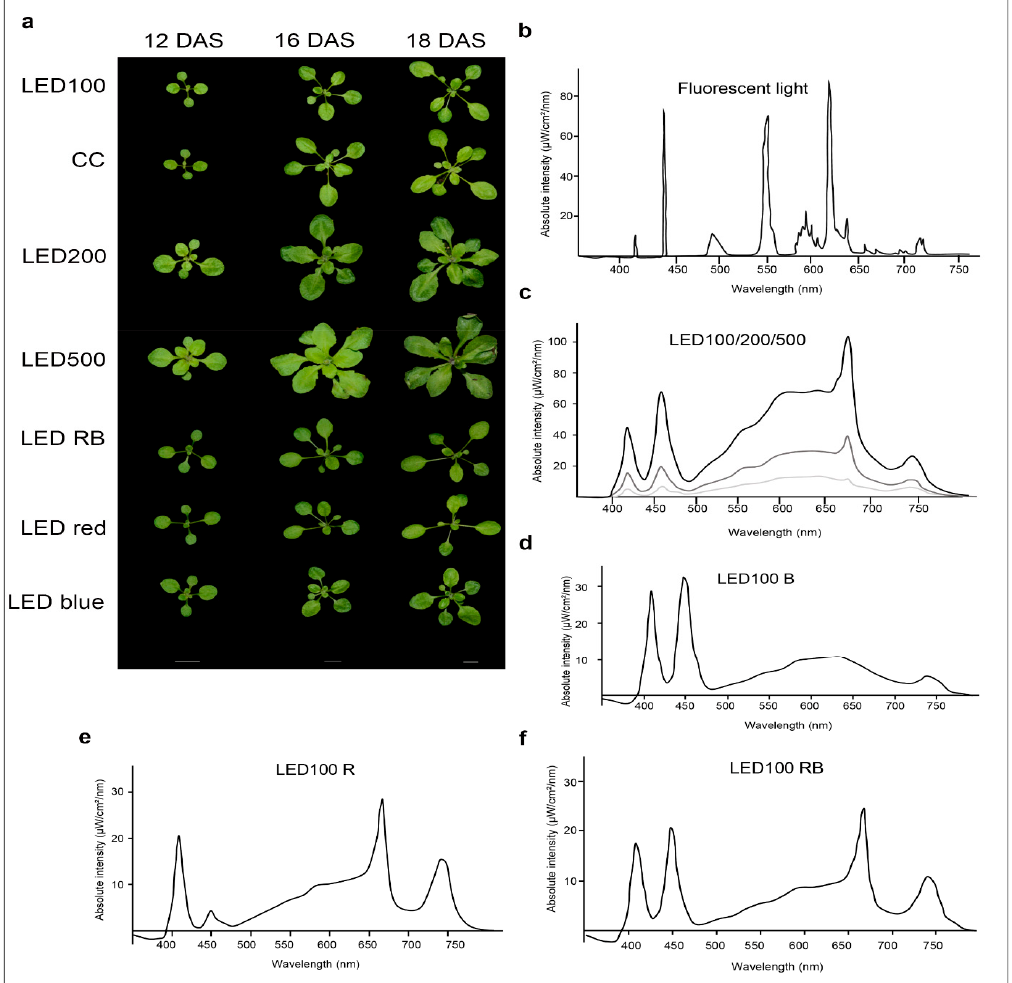
Figure 1. Arabidopsis thaliana shows distinct growth behaviour under different light and climate regimes. ( a ) Phenotypes of plants grown at either 100 µmol m − 2 s − 1 under white light-emitting diode (LED) light (LED100) or fluorescent light in a climatic chamber, or LED light at 200 µmol m − 2 s − 1 or 500 µmol m − 2 s − 1 LED red, LED blue or LED red/blue. Plants were grown on soil and photographed at 12, 16, and 18 days after sowing (DAS). The scale bar represents 1 cm; ( b – f ) Spectra of the different light regimes. Please note that the total light intensity represents the area below the spectral curves. Thus, the peak heights at the different wavelengths do not reach the value of the total output; ( b ) Spectrum of the fluorescent lamp in the climate chamber; ( c ) LED spectra at 100 (lower light grey curve), 200 (middle dark grey curve), and 500 µmol m − 2 s − 1 (upper black curve); ( d ) LED spectrum for LED100 with a raised portion of blue light (B); ( e ) LED spectrum for LED100 with a raised portion of red light (A); ( f ) LED spectrum for LED100 with a raised portion of red/blue light R/B).